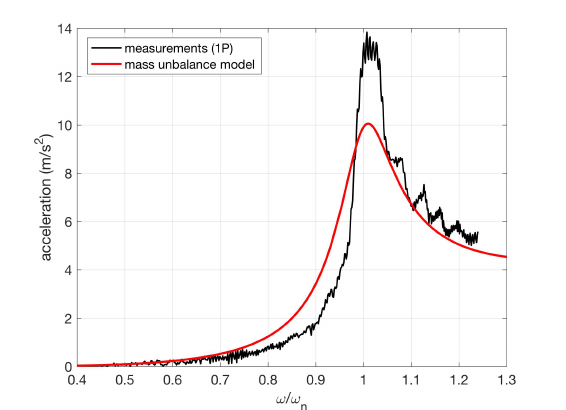
Figure 16. Comparison of measured acceleration on tower in Y direction, band-passed around the 1P frequency, against the amplitude of the acceleration predicted by the unbalanced mass model.